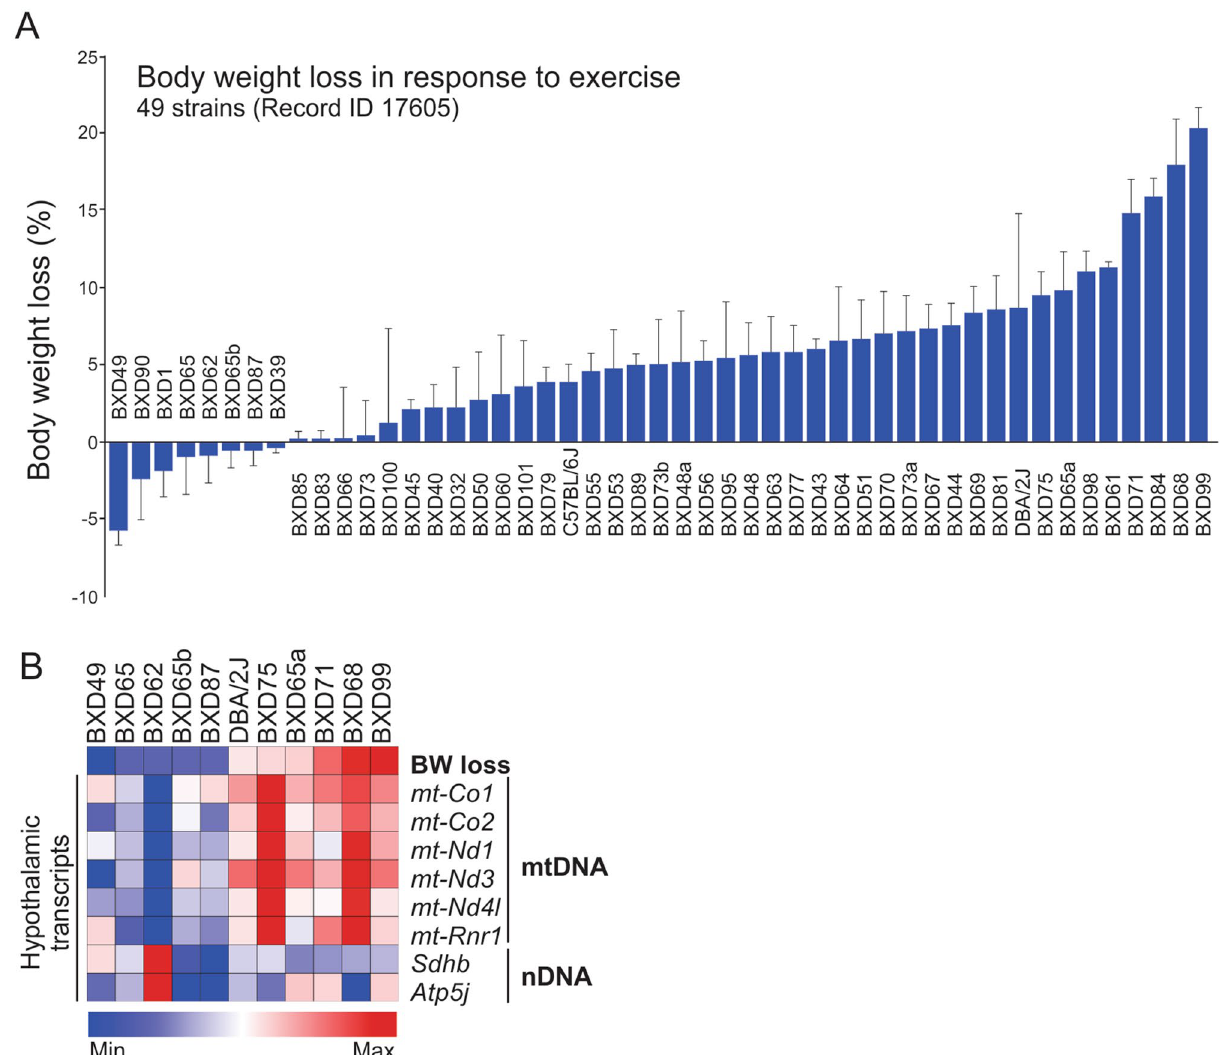
Figure 2. Evaluation of hypothalamic transcripts in exercised BXD cohorts. ( A ) Percentage of body weight loss in response to 3 weeks of voluntary exercise. ( B) Hypothalamic transcripts from mitochondrial and nuclear DNA. Both graphs were edited in CorelDRAW 2019 software (version 21.0.0.593—https ://www.corel draw.com/